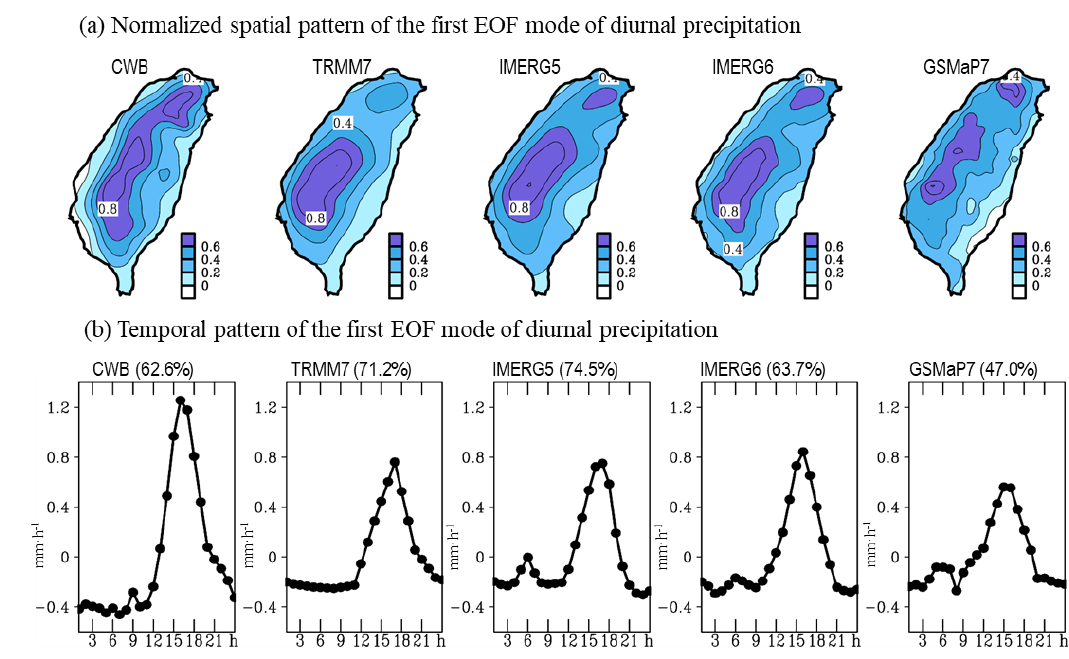
Figure 5. The first empirical orthogonal function (EOF) mode of diurnal precipitation, averaged during the summers of 2014 – 2017: ( a ) the normalized spatial patterns (i.e., eigen-vectors normalized to the maximum precipitation), and ( b ) the temporal patterns (i.e., eigen-coefficients). The percentages (%) of the total variability in hourly precipitation explained by the first EOF mode are added in ( b ). Table 2. Statistical values for the comparison between the CWB data and SPPs shown in Figure 5. The unit of RMSE is mm d -1 . The lowest value of Scorr and Tcorr, as well as the highest value of RMSE, are marked by *. The sample size of spatial variation is 392 grid points. The sample size of temporal variation is 24 hours.